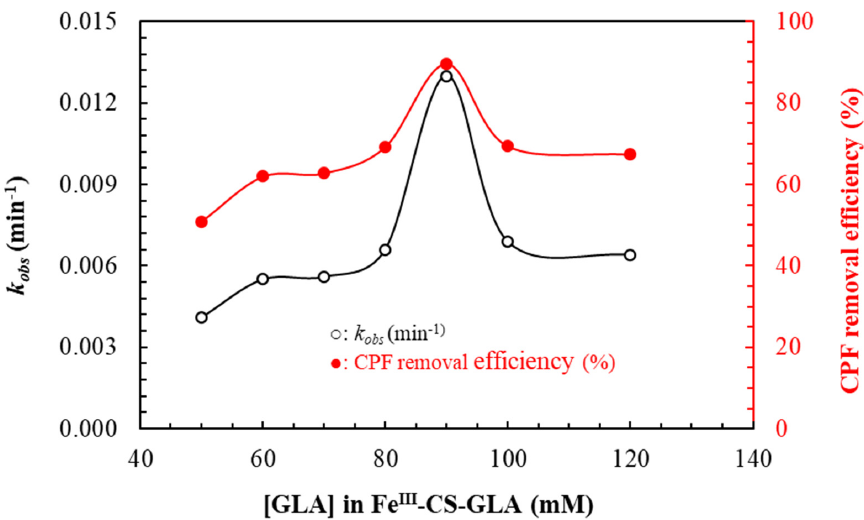
Figure 8. The effects of [GLA] 0 in Fe III -CS-GLA on k obs (min − 1 ) and CPF removal efficiency (%) ob-